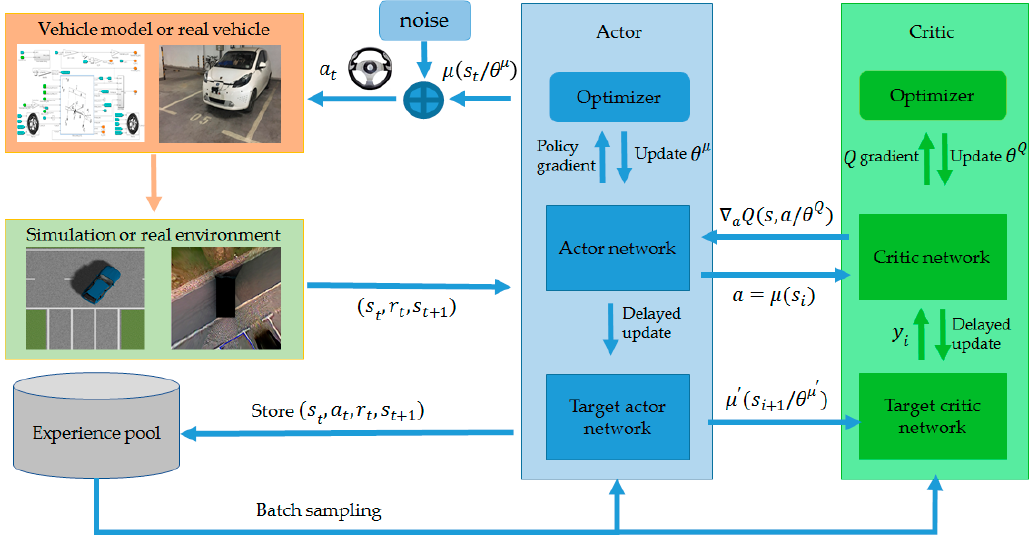
Sensors 2019 , 19 , x FOR PEER REVIEW